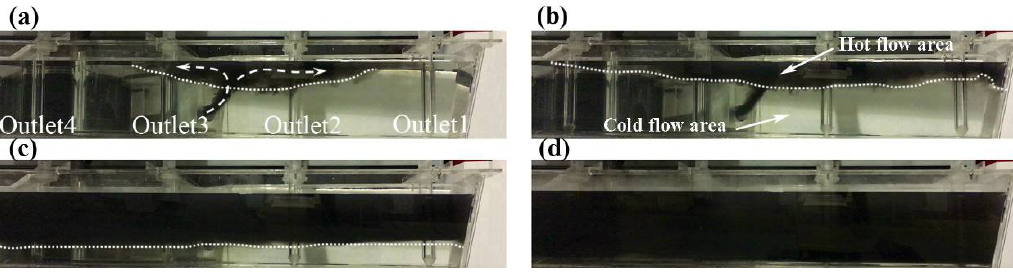
Figure 7. Ink dispersion behavior in the case A4: ( a ) 56 s, ( b ) 76 s, ( c ) 311 s, ( d ) 585 s.